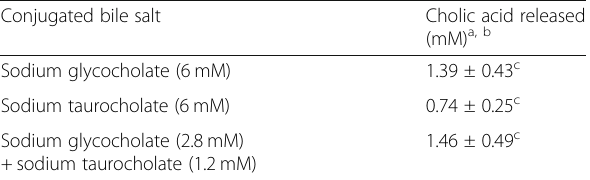
Table 4 Deconjugation of glycocholate and taurocholate or their combination by Lactococcus lactic subsp. lactis a, b